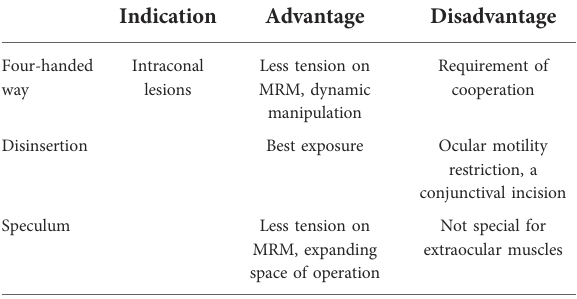
TABLE 2 Comparison of MRM retraction